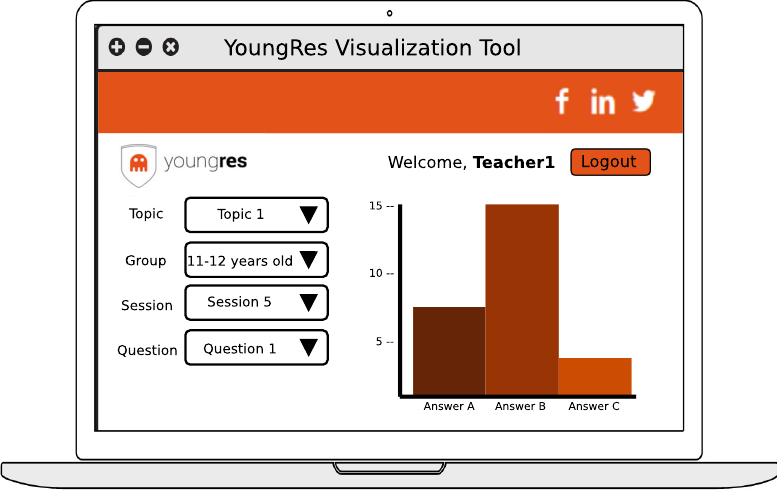
Fig. 5. GUI of the Visualization tool of the YoungRes project. In this example, any teacher could easily visualize how many youngsters have selected the di®erent options in a speci¯c question of the video